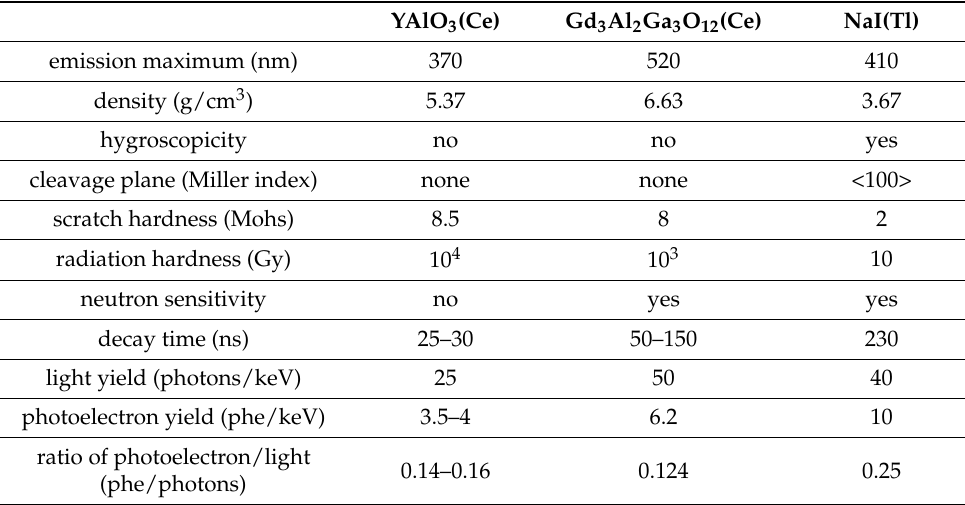
Table 2. Major characteristics of YAlO 3 (Ce), Gd 3 Al 2 Ga 3 O 12 (Ce), and